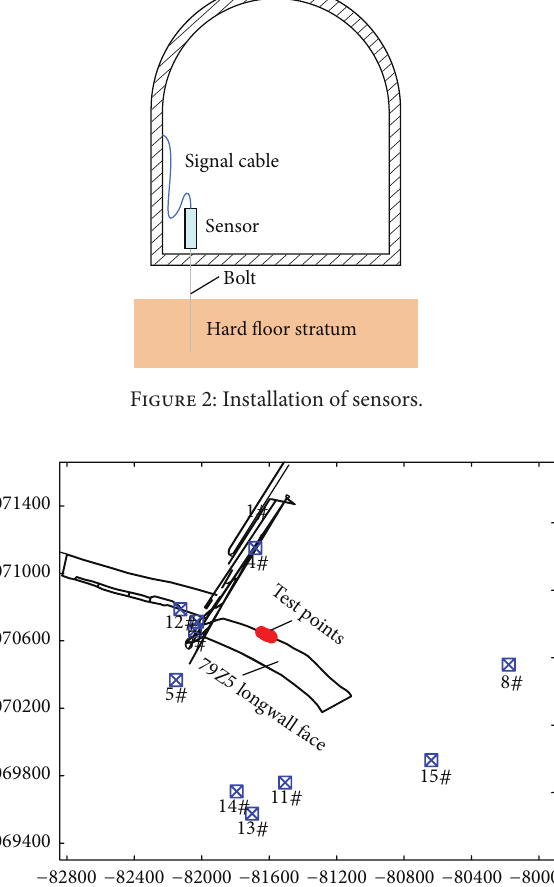
Table 1: Basic parameters in the in situ